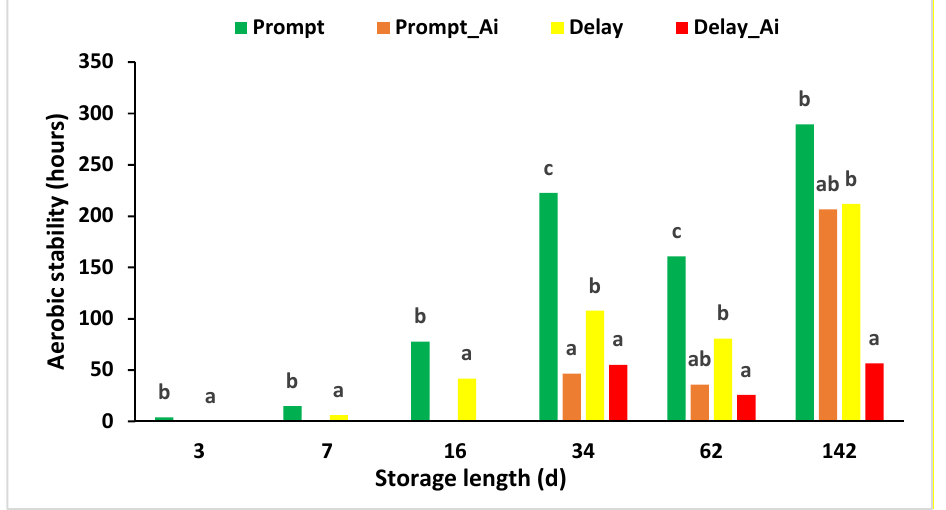
Figure 3. Aerobic stability during the course of fermentation of maize silage as affected by sealing time and repeated air ingress during storage of maize silage over 142 days. Least square means are presented with standard error of means as error bars, significant differences within respective storage length are given below as plot table (a–c: means with no common letter differ at p < 0.05; pairwise comparisons by rank procedure). Prompt, promptly sealed, without air ingress during storage; Prompt_Ai, promptly sealed with air ingress after 27, 55, 135 days of storage; Delay, sealed with 24 h delay, without air ingress during storage; Delay_ Ai, sealed with 24 h delay and air ingress after 27, 55, 135 days of